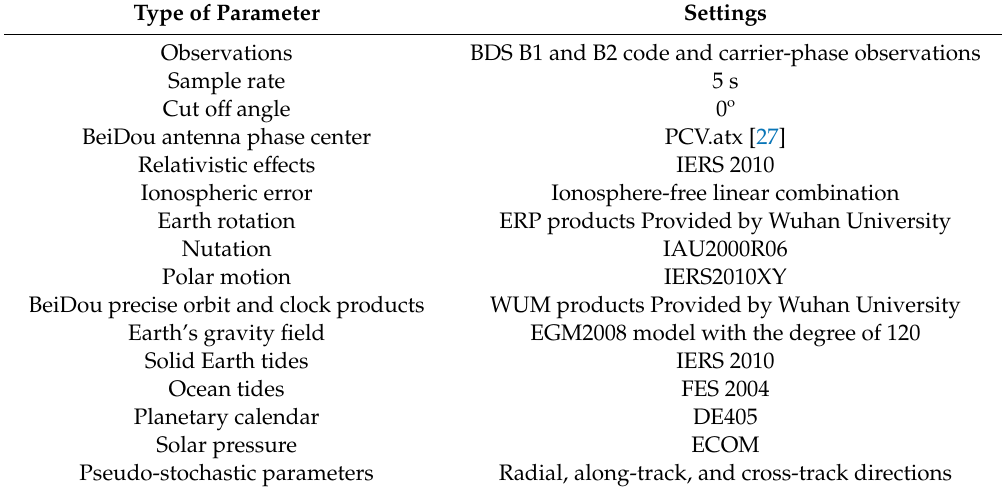
Table 1. The data processing strategies for Luojia-1A satellite